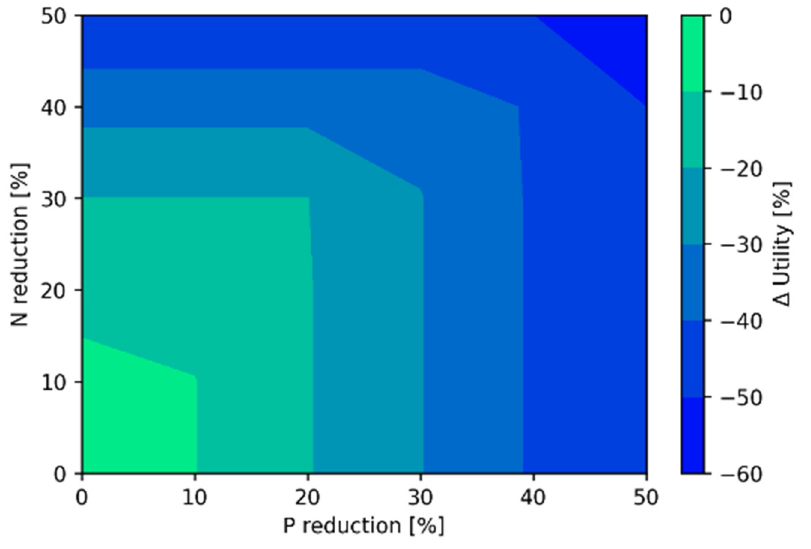
Figure 4. Change of annual utility with respect to the baseline for varying P or N reductions using the 2nd version of the model.